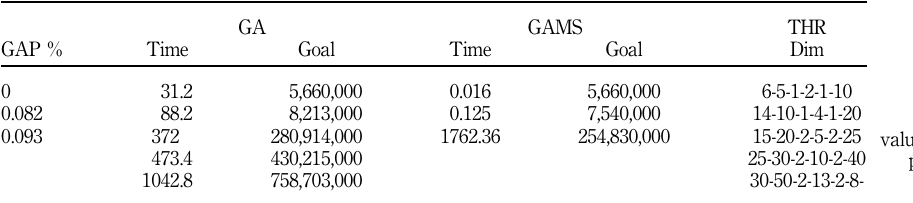
Table 2. Objective function